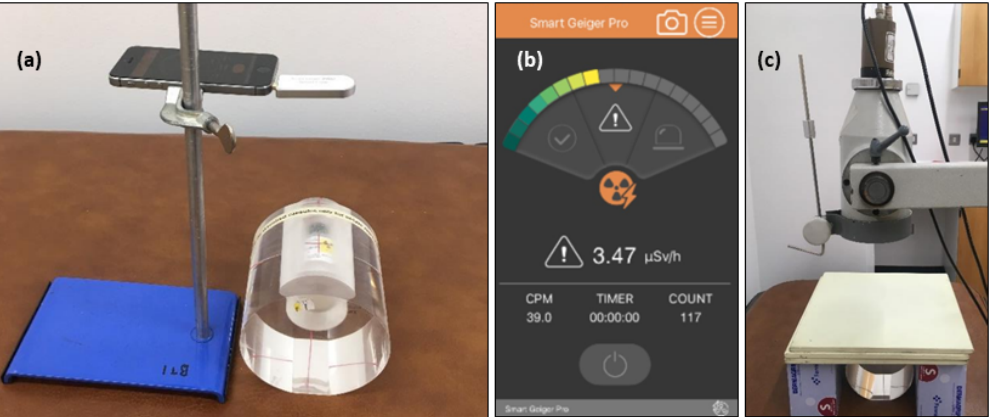
Figure 1. ( a ) Photograph of Smart Geiger Pro (SGP) radiation sensor, attached to smartphone via headphone jack, fixed by a retort stand at a distance of 20 cm from the I-131 source. The I-131 source is held in the anterior portion of a Biodex thyroid uptake neck phantom, simulating the position and resultant attenuation of activity from the thyroid gland in a patient’s neck; ( b ) Image of SGP smartphone app user interface; ( c ) Photograph of standard hospital-grade thyroid uptake Ortec sensor positioned vertically above the tissue-mimicking water phantom layers and the I-131 capsule embedded in the thyroid uptake neck phantom.